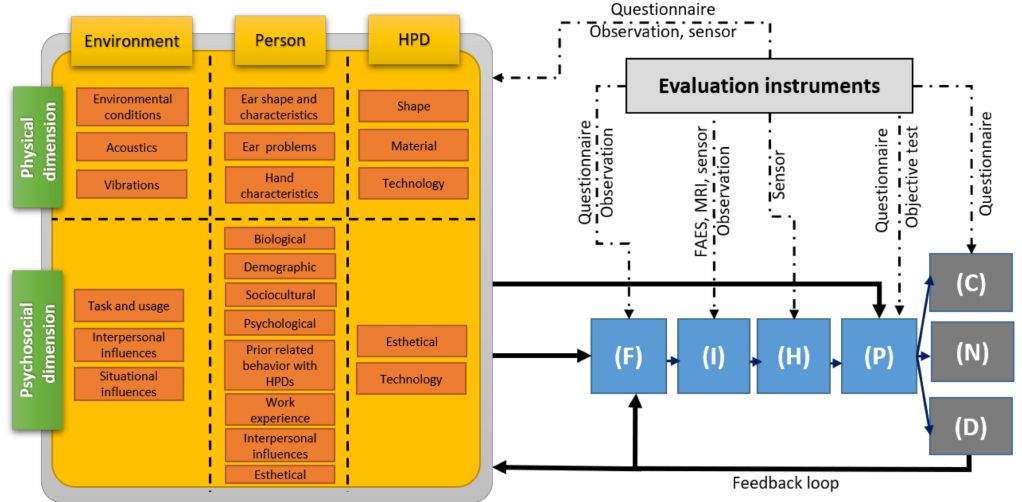
Figure 1. HPD comfort model. Acronyms used in this figure: “Fitting/Positioning” phase ( F ), the “Interaction” phase ( I ), the “internal Human body effects” phase ( H ) and the “Perception” phase ( P ); Comfort ( C ), Discomfort ( D ) or feel Neutral ( N ); Hearing Protection Device (HPD), Field Attenuation Estimation System (FAES), Magnetic Resonance Imaging